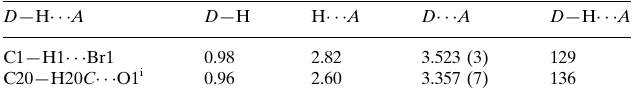
Hydrogen-bond geometry (A˚ , (cid:1)